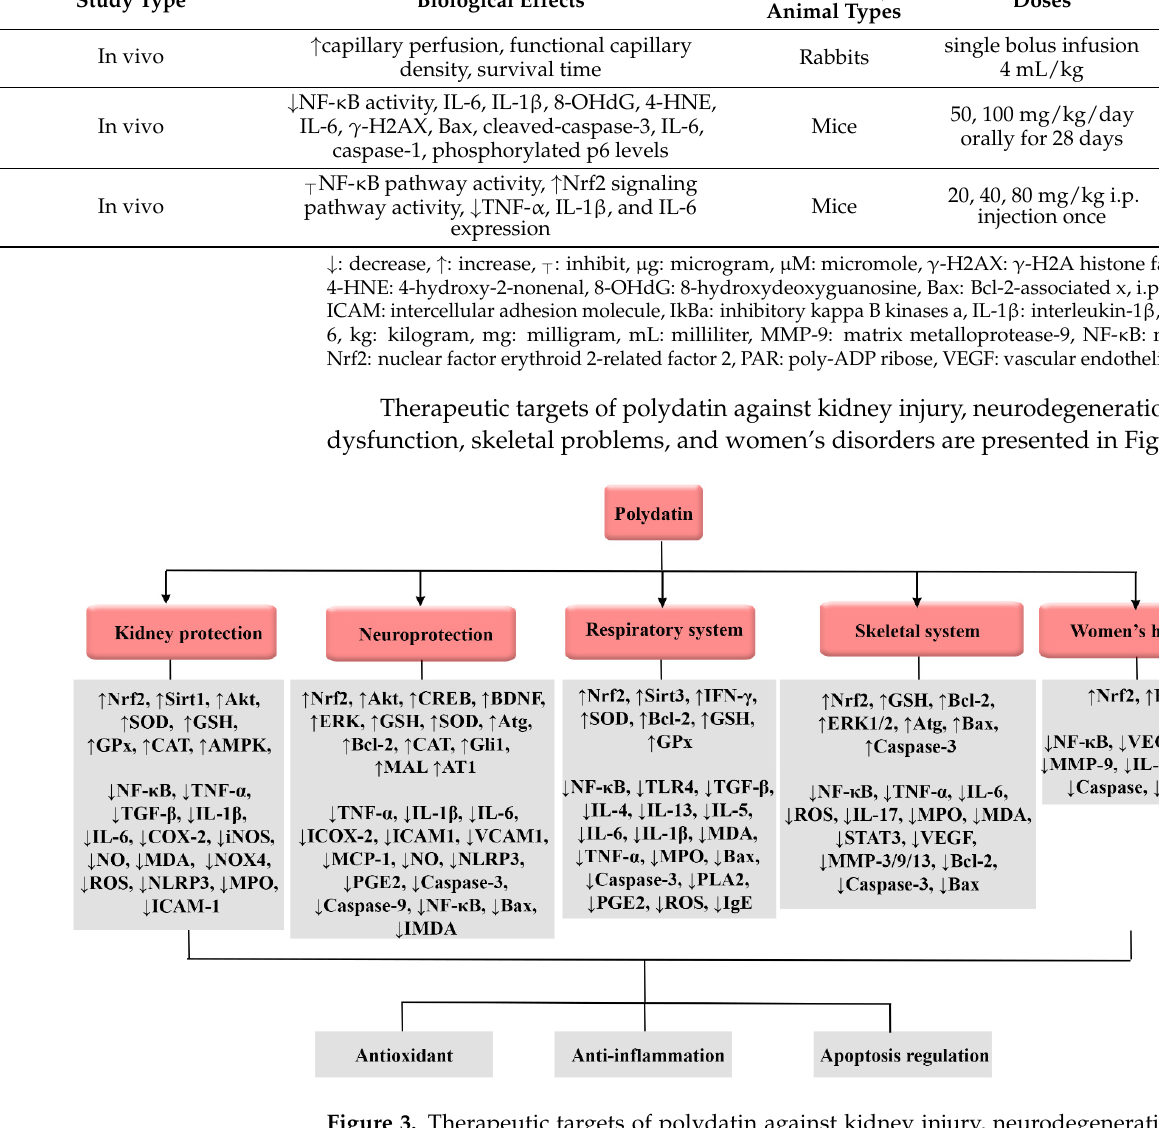
Figure 3. Therapeutic targets of polydatin against kidney injury, neurodegeneration, respiratory